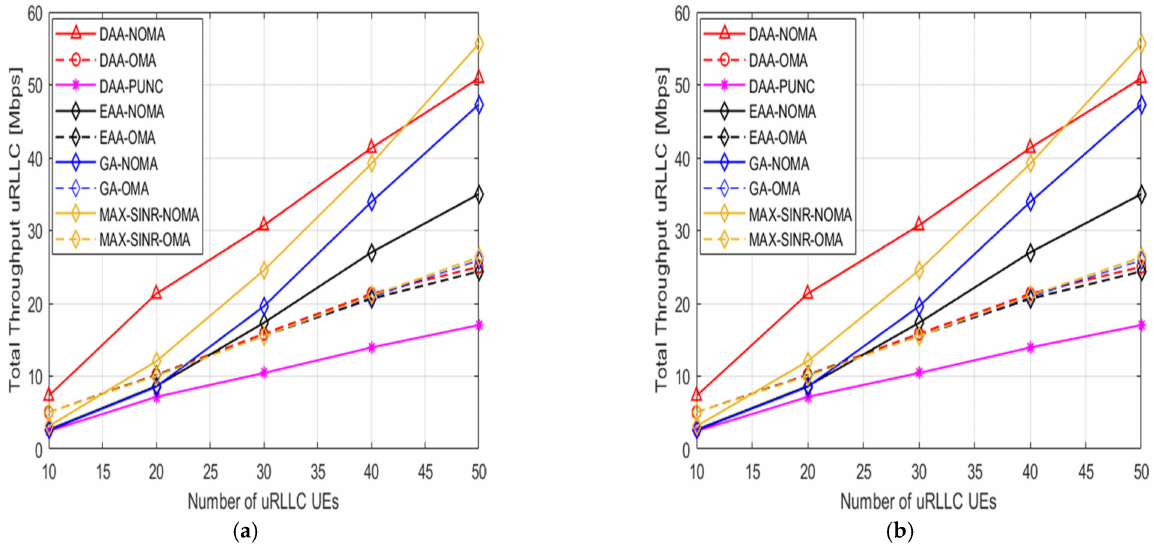
Figure 5. The DL total throughput for uRLLC UEs versus number of uRLLC UEs. ( a ) Ґ nm be > Ґ nm bl . ( b ) Ґ nm bl > Ґ nm be